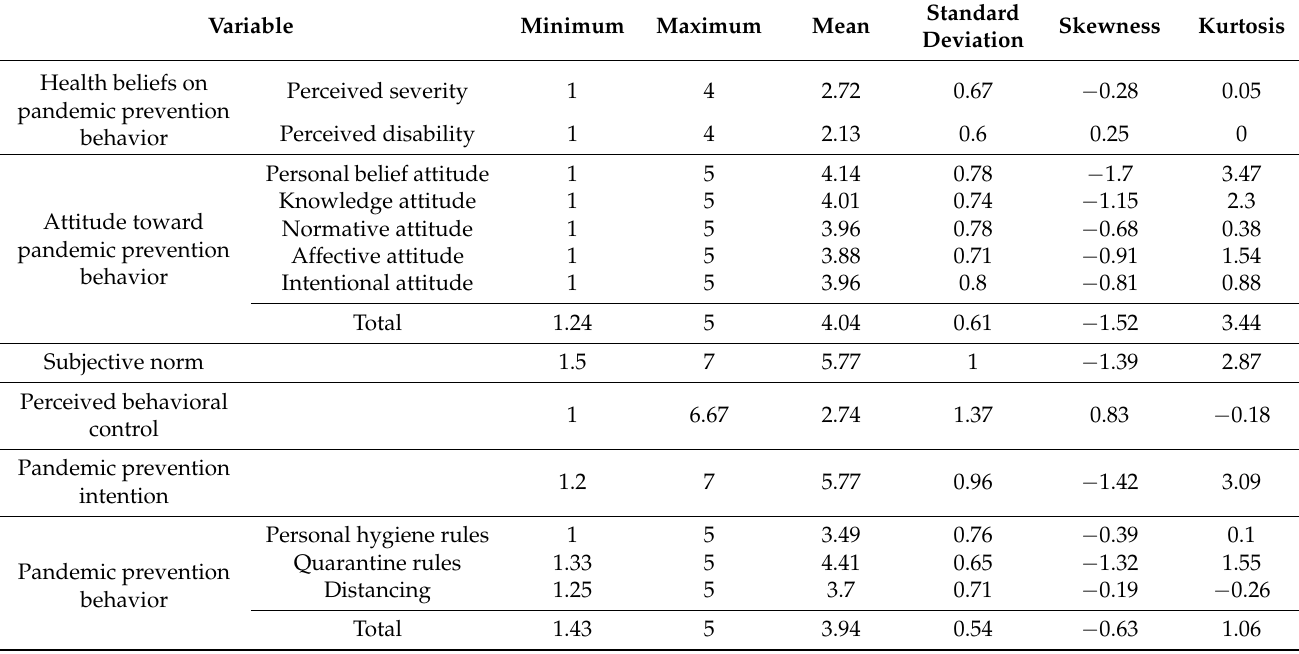
Table 2. Descriptive statistics of the study variables.